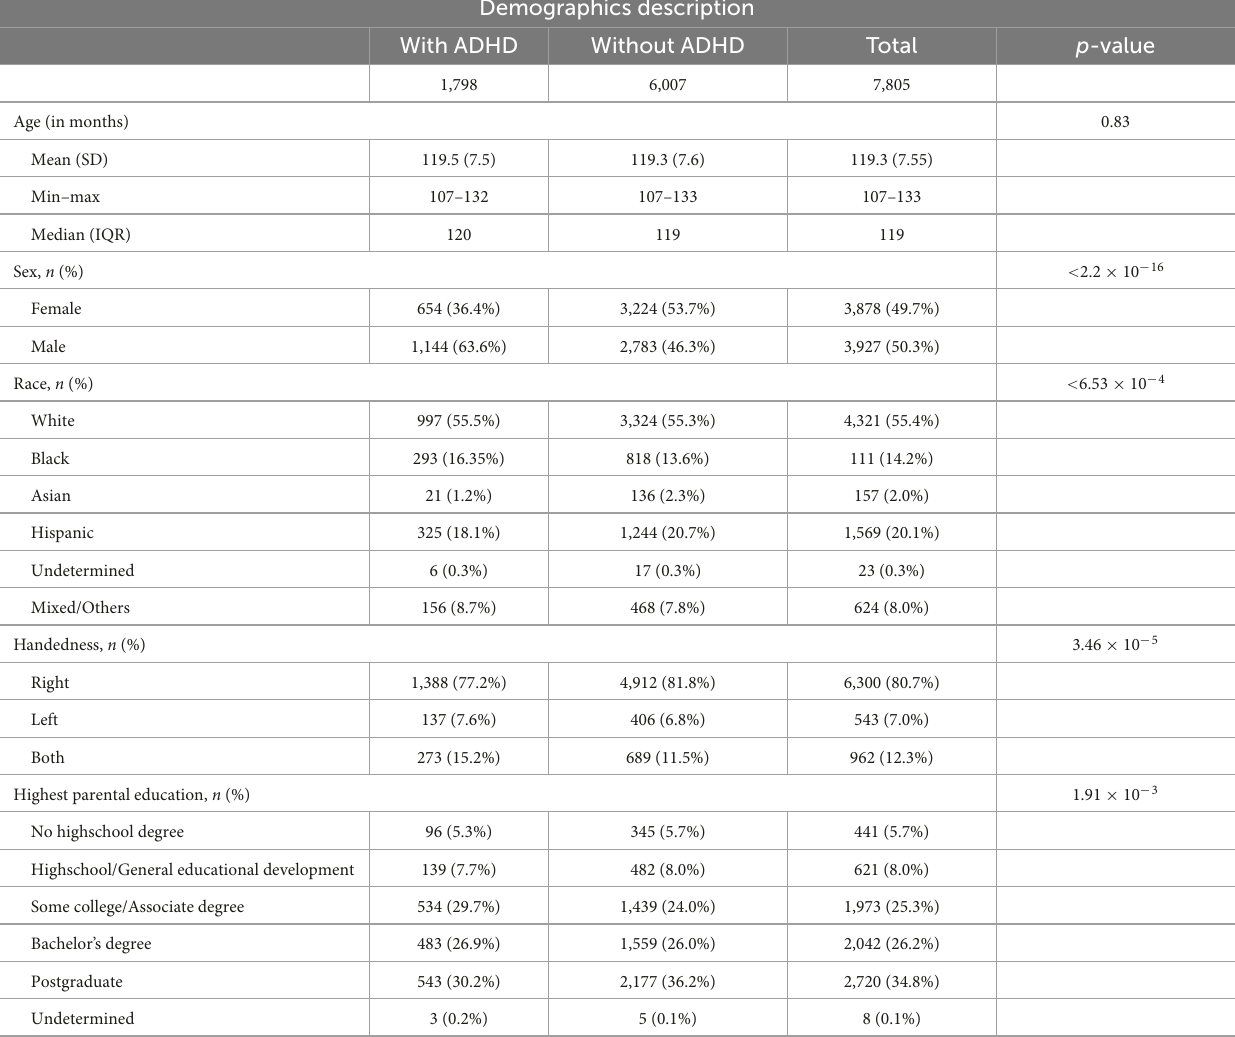
TABLE 1 Characteristics of children with and without ADHD